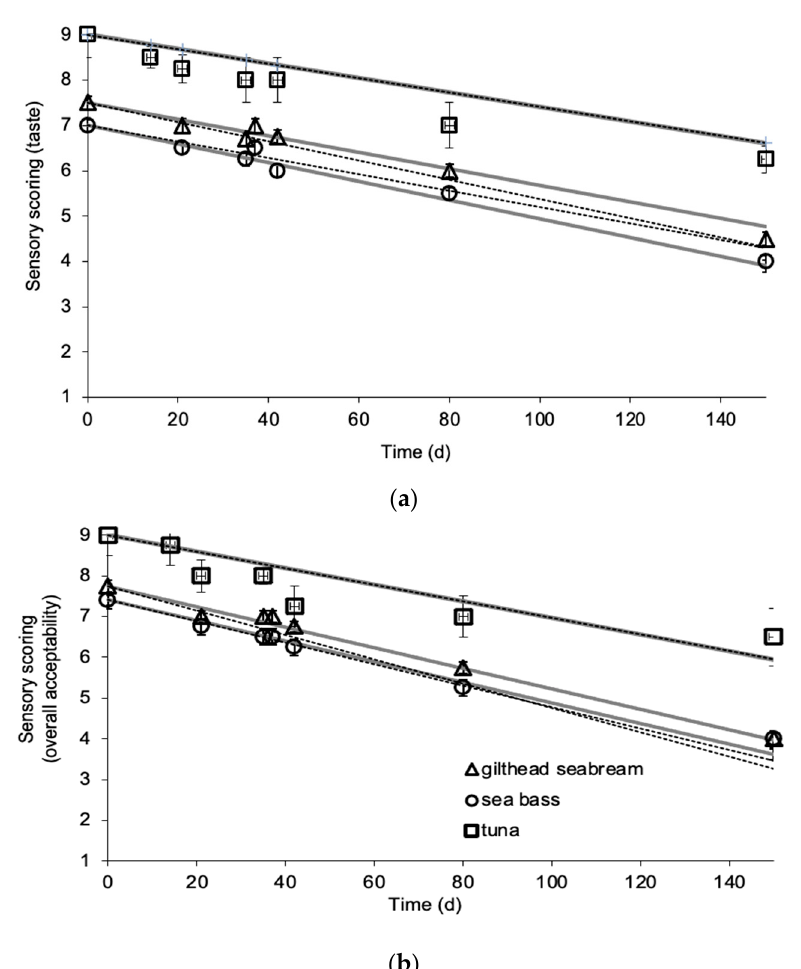
Figure 6. Comparison of experimental and predicted changes in ( a ) taste and ( b ) overall acceptability of gilthead sea bream fillets, sea bass fillets and yellowfin tuna slices at the temperature profile of the non-isothermal experiment. The gray solid lines indicate predictions by Method #1, the black dashed lines indicate the predictions by Method #2, and the data points present the experimental values. (Error bars indicate standard error of scoring of eight panelists.)